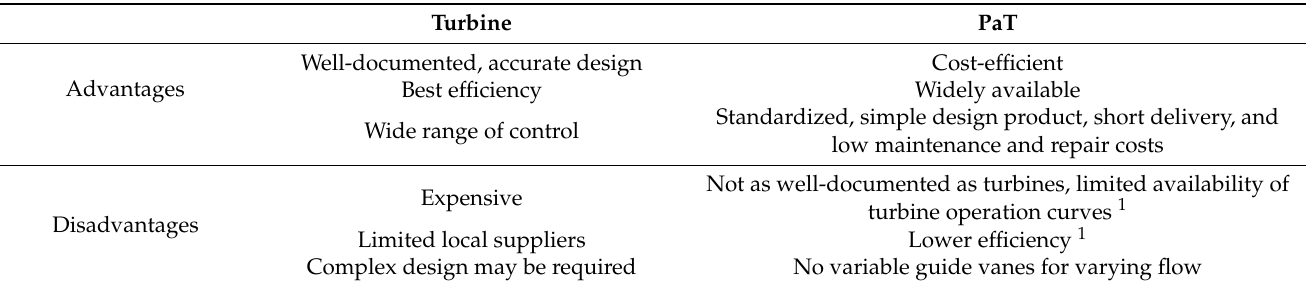
Table 1. Major differences between turbines and PaTs. Turbine PaT Well-documented, accurate design Cost-efficient Advantages Best efficiency Widely available Standardized, simple design product, short delivery, Wide range of control